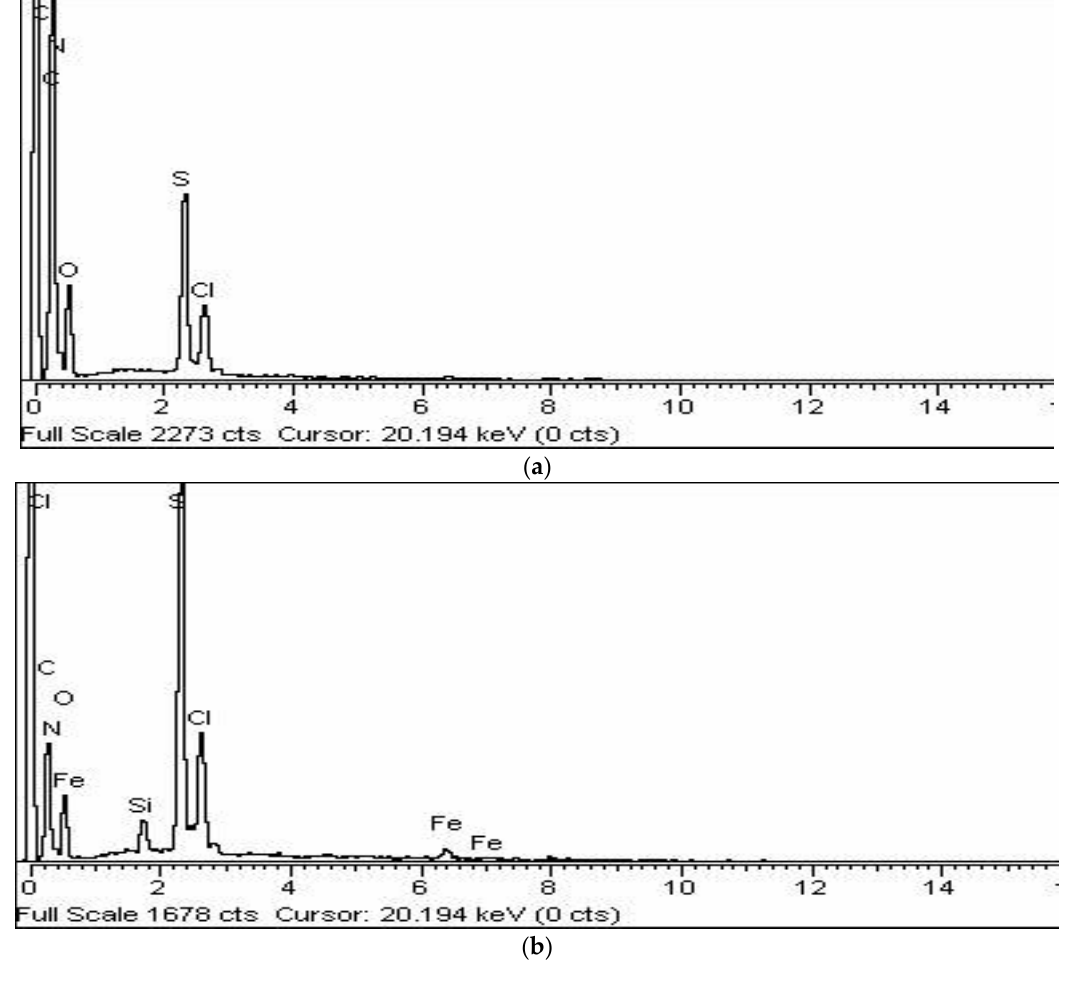
Figure 6. Energy dispersive X-ray (EDX) spectra of ( a ) COP ( b ) RGO/COP.